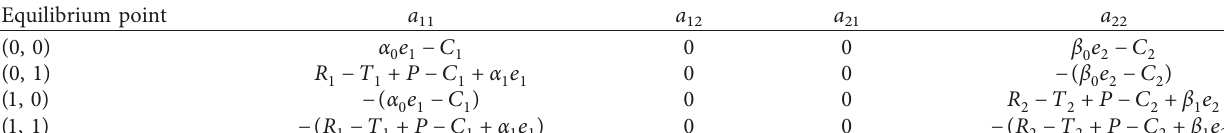
Table 8: Values of a 11 , a 12 , a 21 , and a 22 at the local stable equilibrium point. Equilibrium point